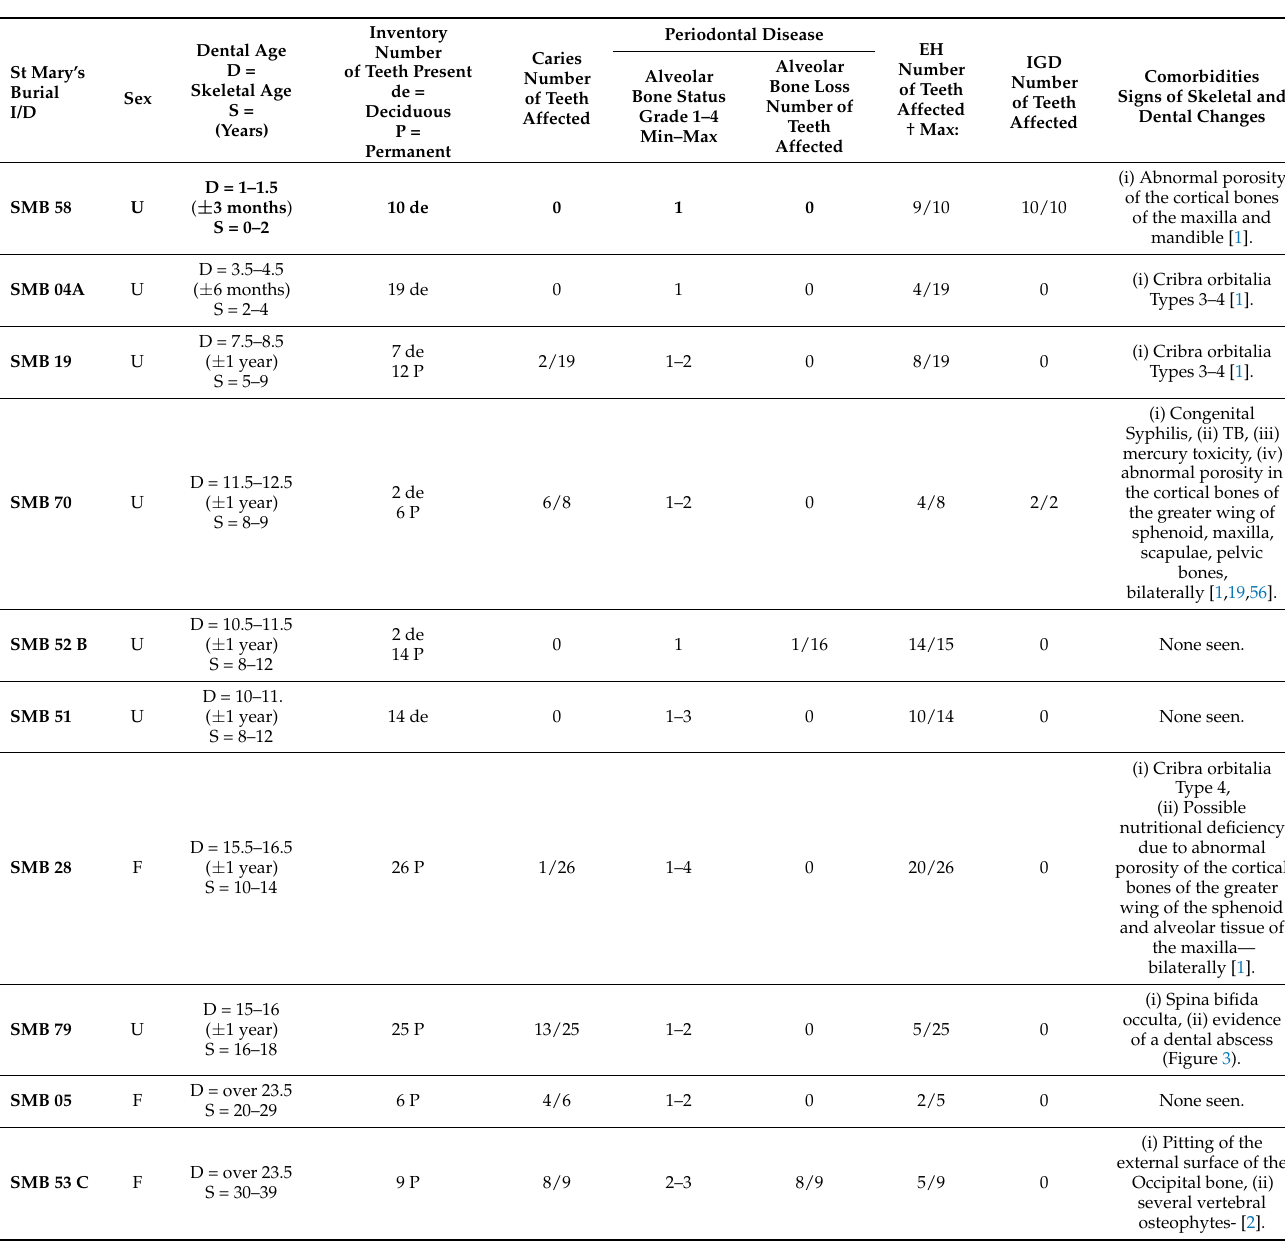
Table 7. Key individuals from the St Mary’s Cemetery sample with a summary of their oral health findings. Many individuals had one or more skeletal signs of a comorbidity and/or signs of skeletal and dental